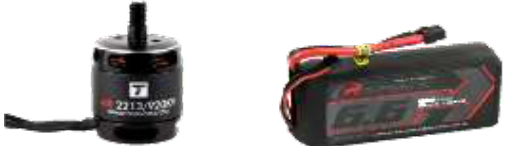
Fig. 5. Engine and Battery for UAV